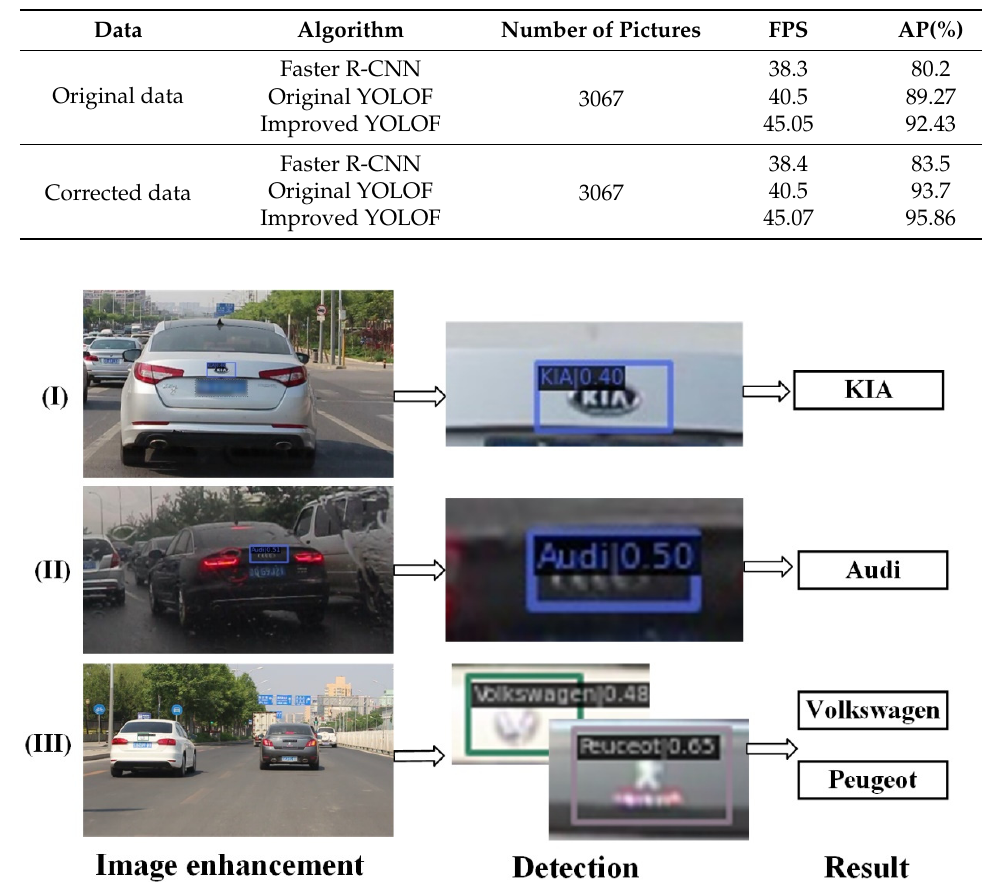
Figure 6. Results of moving vehicles’ logo detection [38]. (I) is images under normal